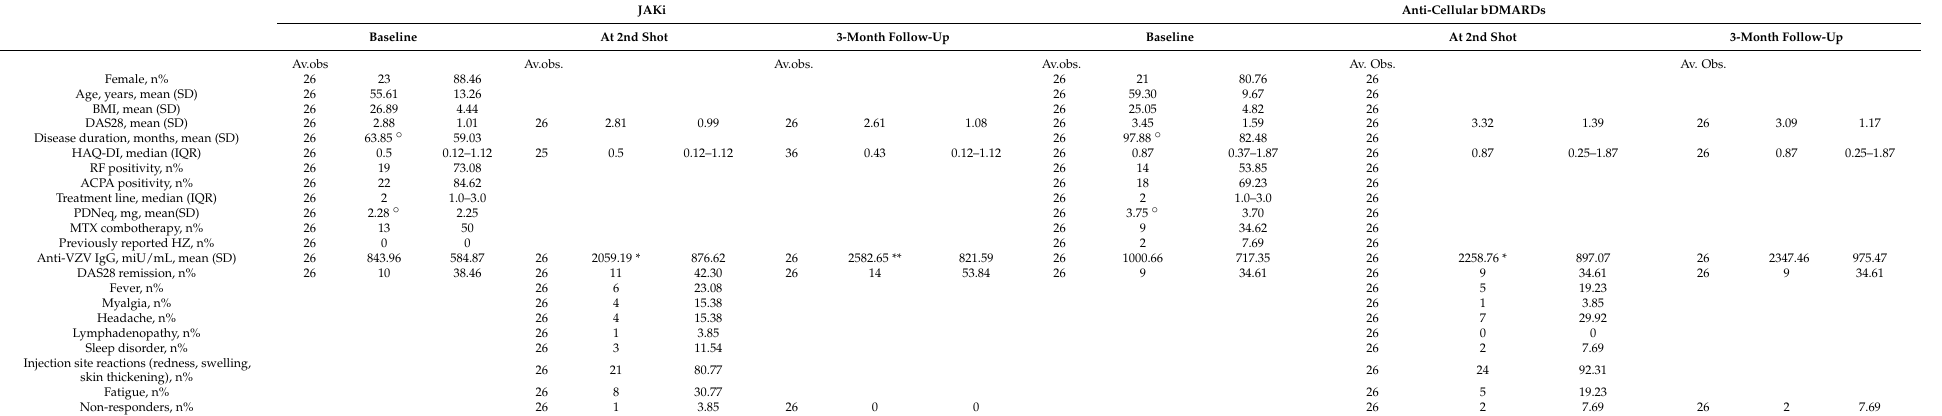
Table 1. Patient characteristics at different follow-up times. * p < 0.001 (previous time point, same group), ** p = 0.03 (previous time point, same group), ◦ p = 0.04 (group